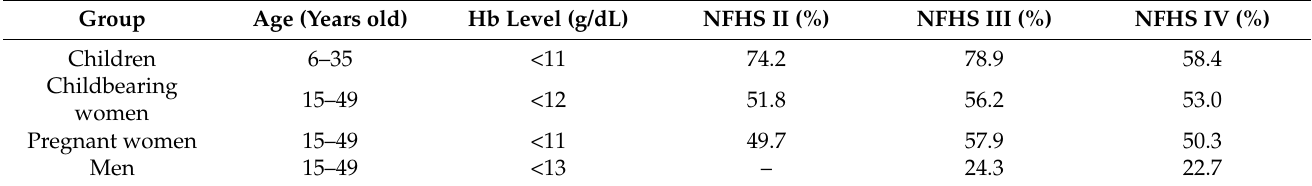
Table 1. Prevalence of IDA in India. NFHS means National Family Health Survey (NFHS). Source: Nutrition Atlas,